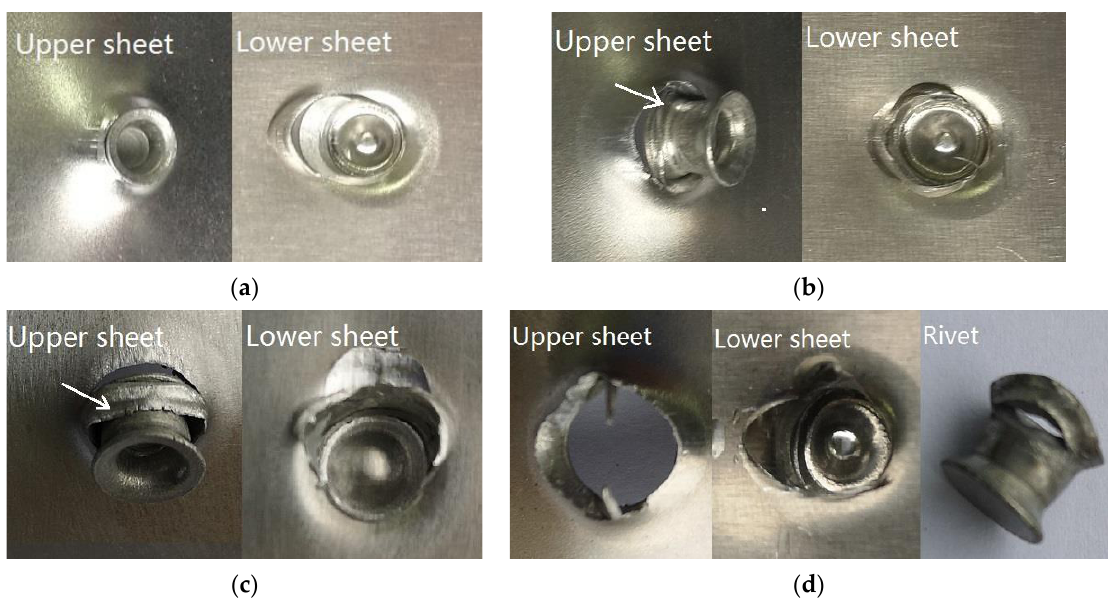
Figure 9. Failure forms of SPFC-AA joints at rivet heights of ( a ) 6 mm; ( b ) 7 mm; ( c ) 8 mm; ( d ) 9 mm.